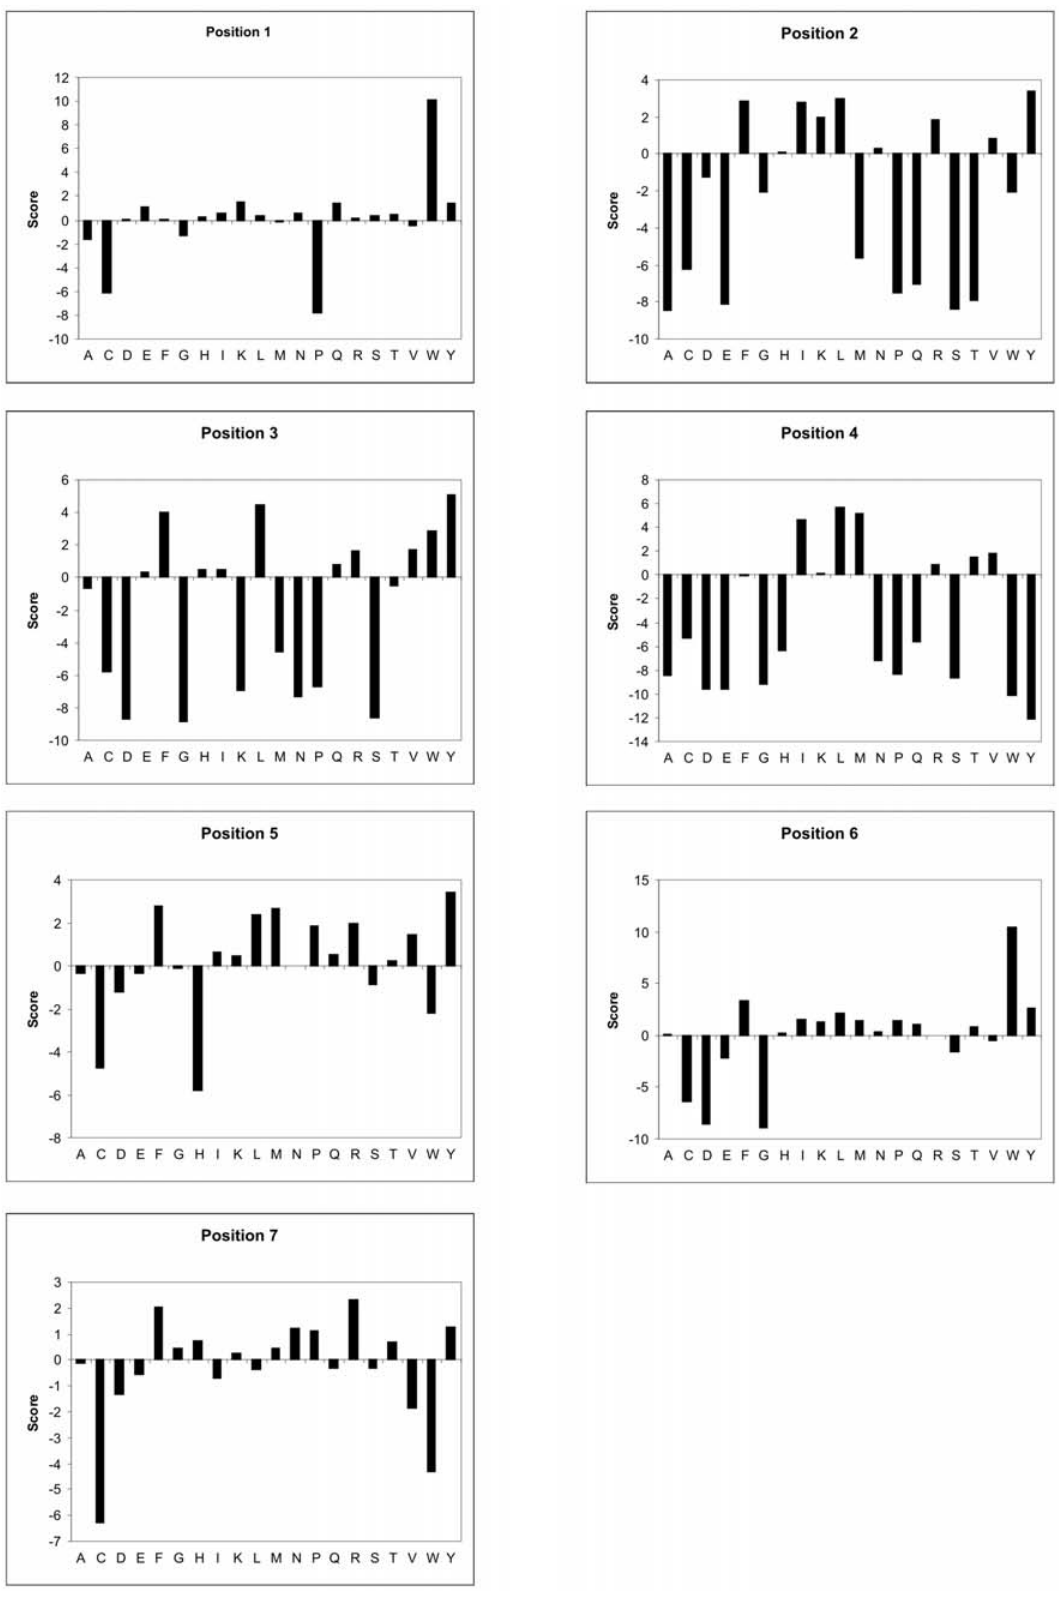
Figure 6. Graphical representation of the final DnaK heptameric binding profile over all aminoacids and all residue positions. The axes crossing point at score zero was chosen for convenience. Position 1 and 7 respectively represent the N-and and C-terminal end of the heptameric motif.